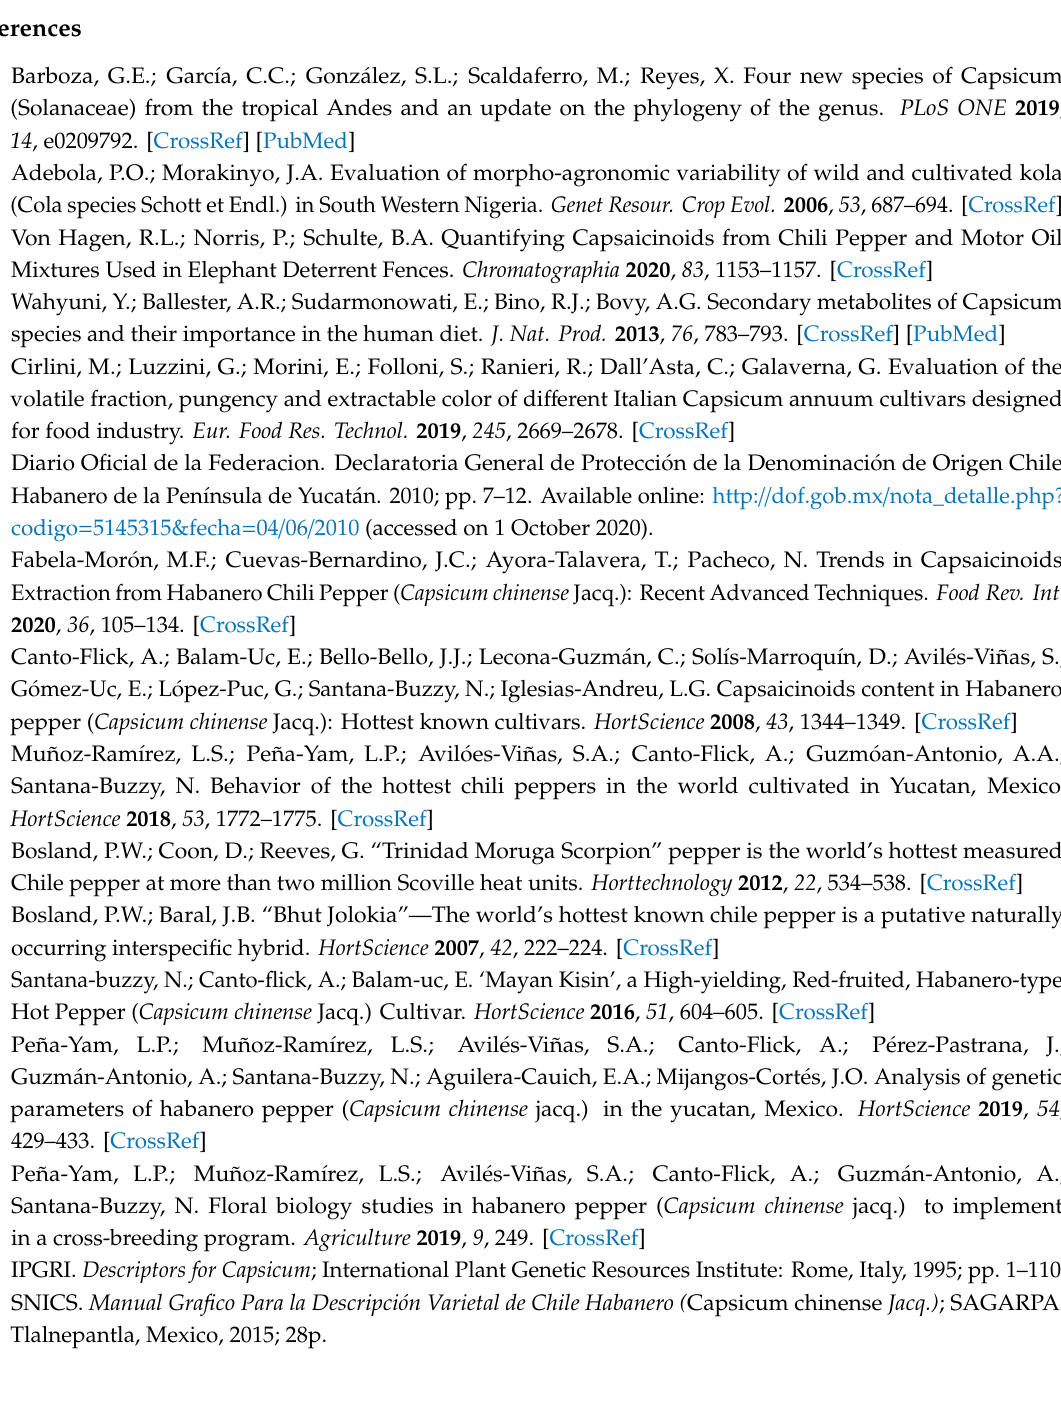
Table S1: Evaluated qualitative descriptors in F1 lines and progenitors of habanero pepper, Table S2: Pearson correlation matrix for the 18 quantitative descriptors of 29 F1 lines and 11 progenitors of habanero